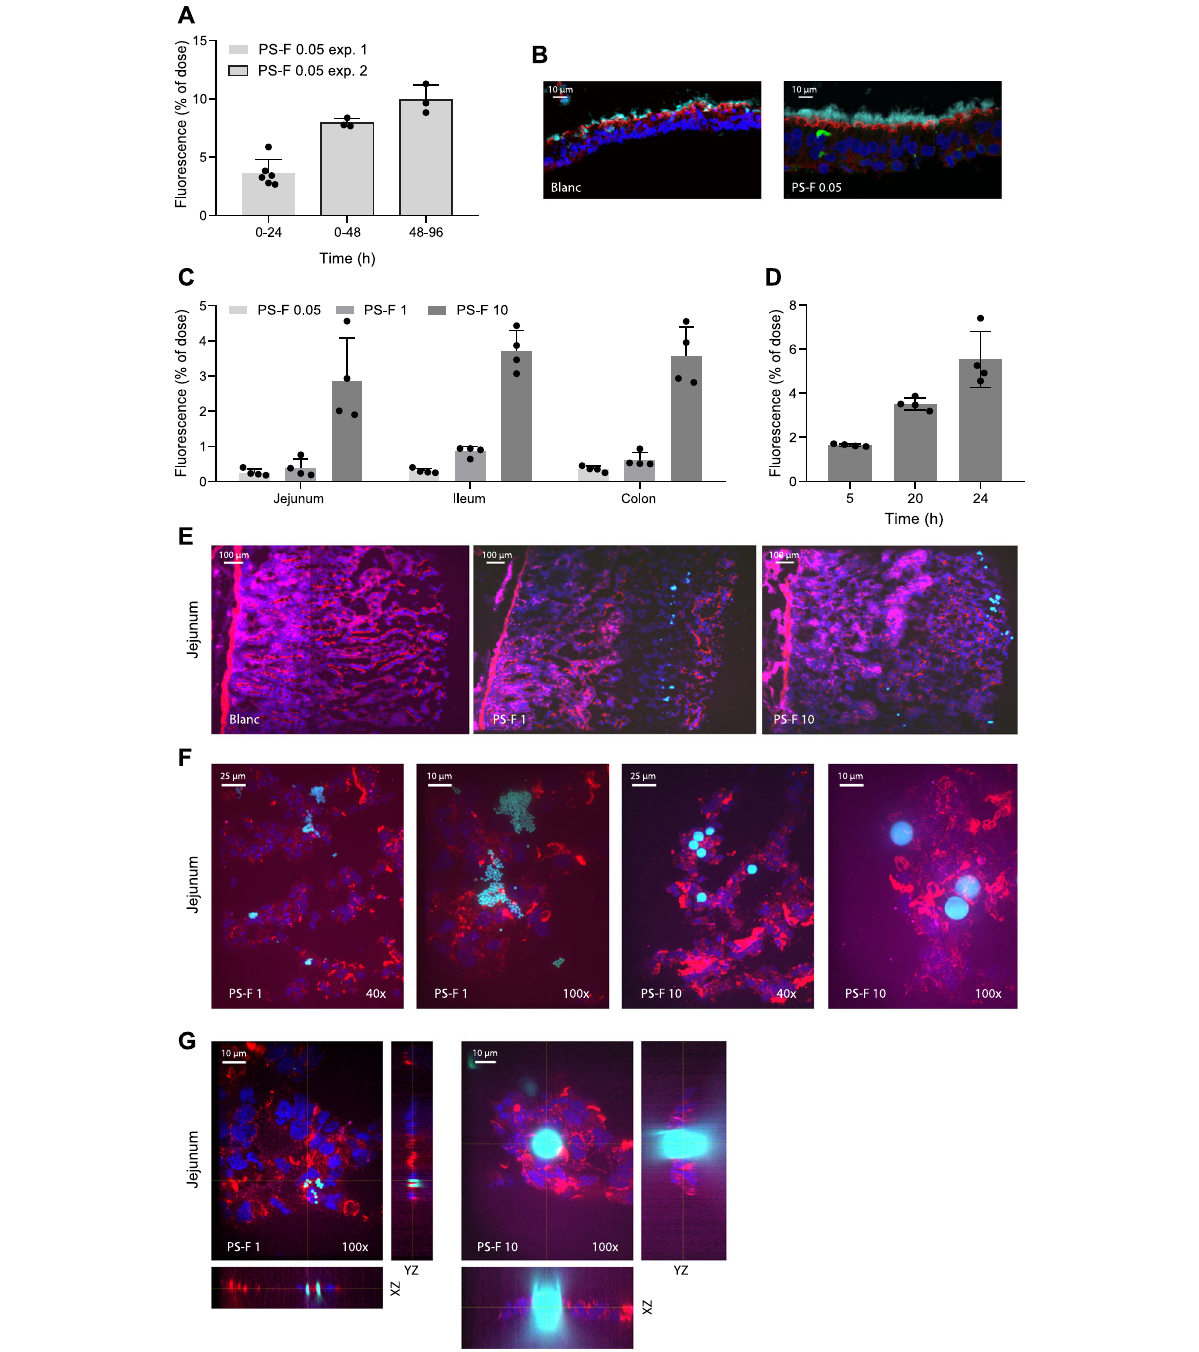
Fig. 5 (See legend on next